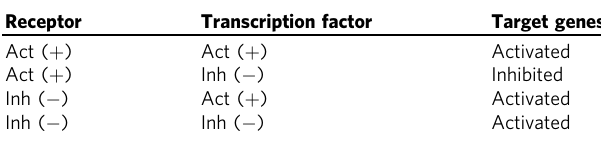
Table 1 Causal reasoning rules for membrane